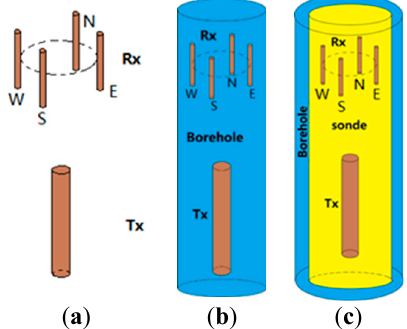
Figure 2. Directional borehole radar schematic diagram (both transmitting and receiving antennas are linear antennas in simulation), ( a ) schematic diagram of directional borehole radar in a uniform medium, ( b ) directional borehole radar diagram including only the borehole, and ( c ) directional borehole radar diagram including both the borehole and sonde.